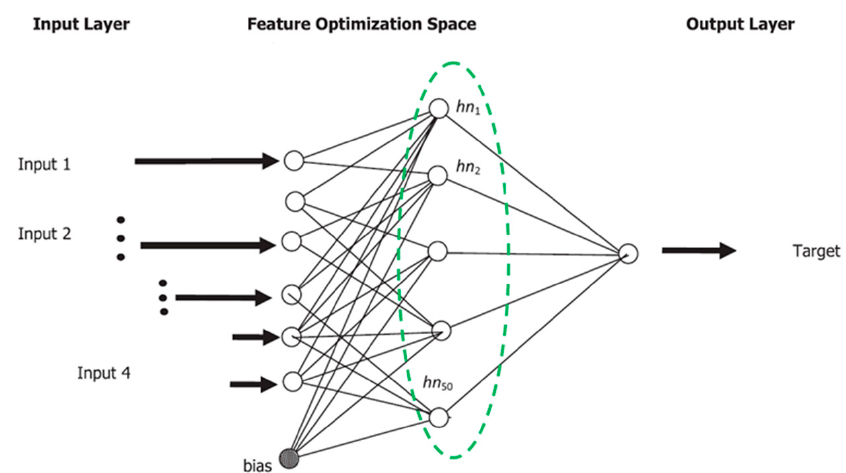
Figure 3. A simple architecture of the extreme learning machine (ELM).